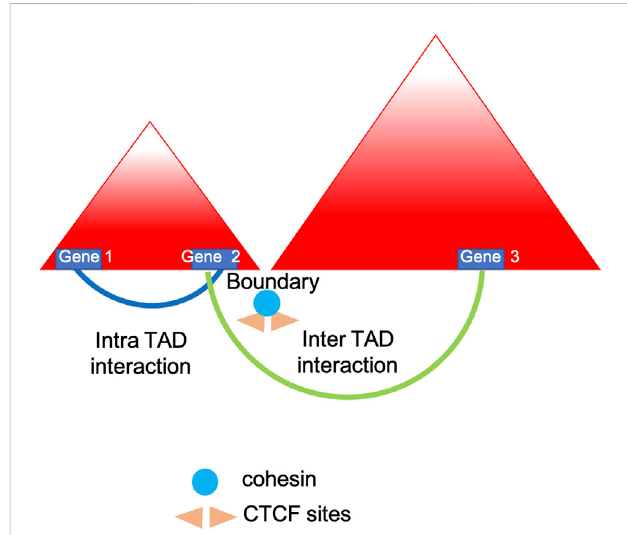
FIGURE 1 TADs insulation. Simpli fi ed model showing how topologically associated domains (TADs) are insulated by borders which are leaky enough to in fl uence and regulate nearby genes expression (Luppino et al.,